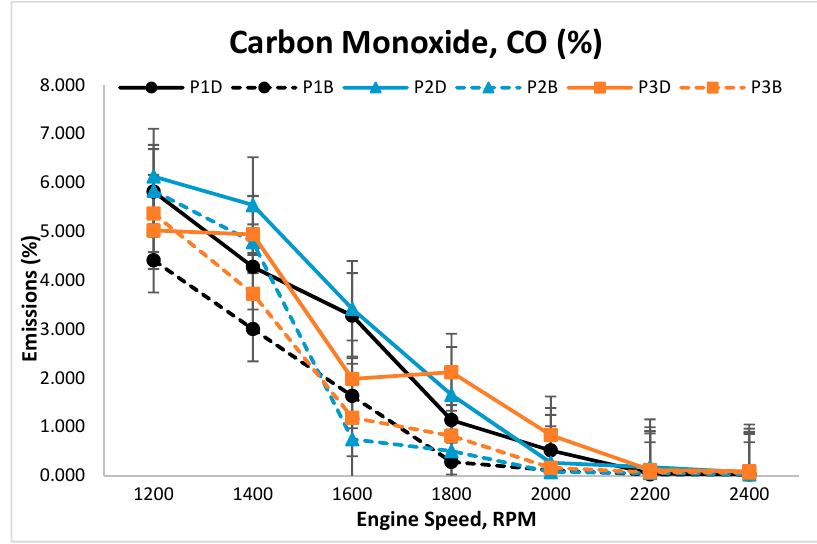
Figure 11. Carbon monoxide (CO) emissions at variable speeds.